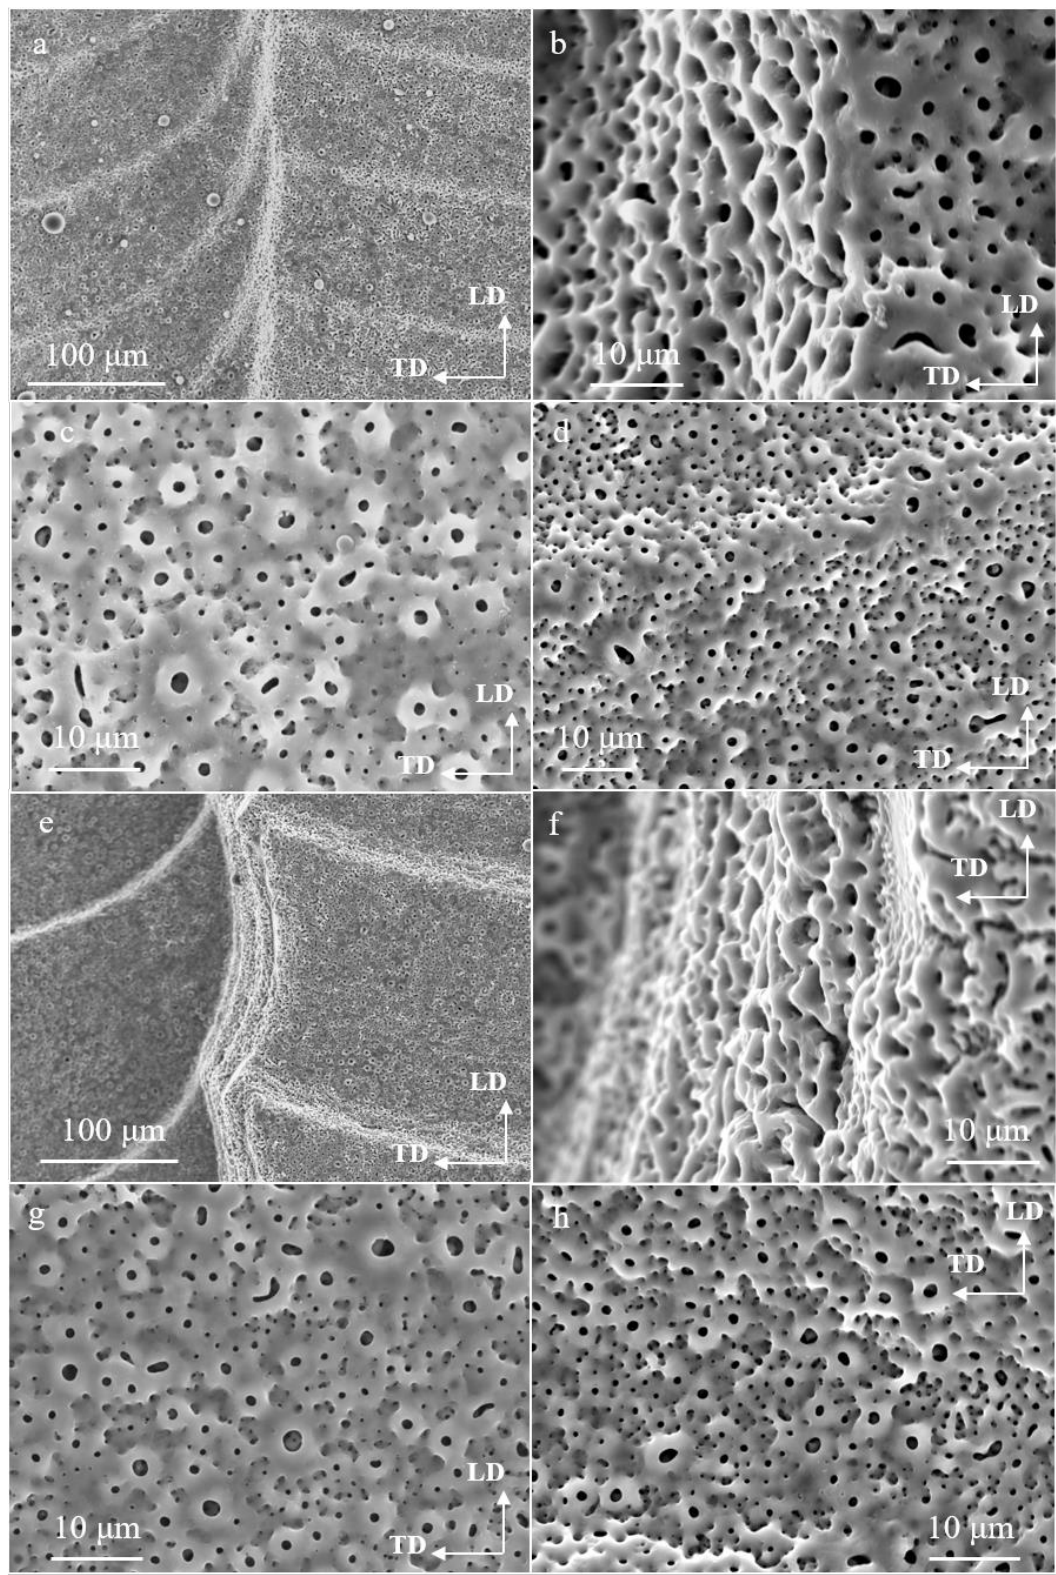
Figure 11. SEM of B1-PEO ( a – d ) and B2-PEO ( e – h ) specimens: ( a , b , e , f ) were taken at the overlapping area; ( c , g ) at the top part of the bridges; and ( d , h ) at over micro-canals formed.